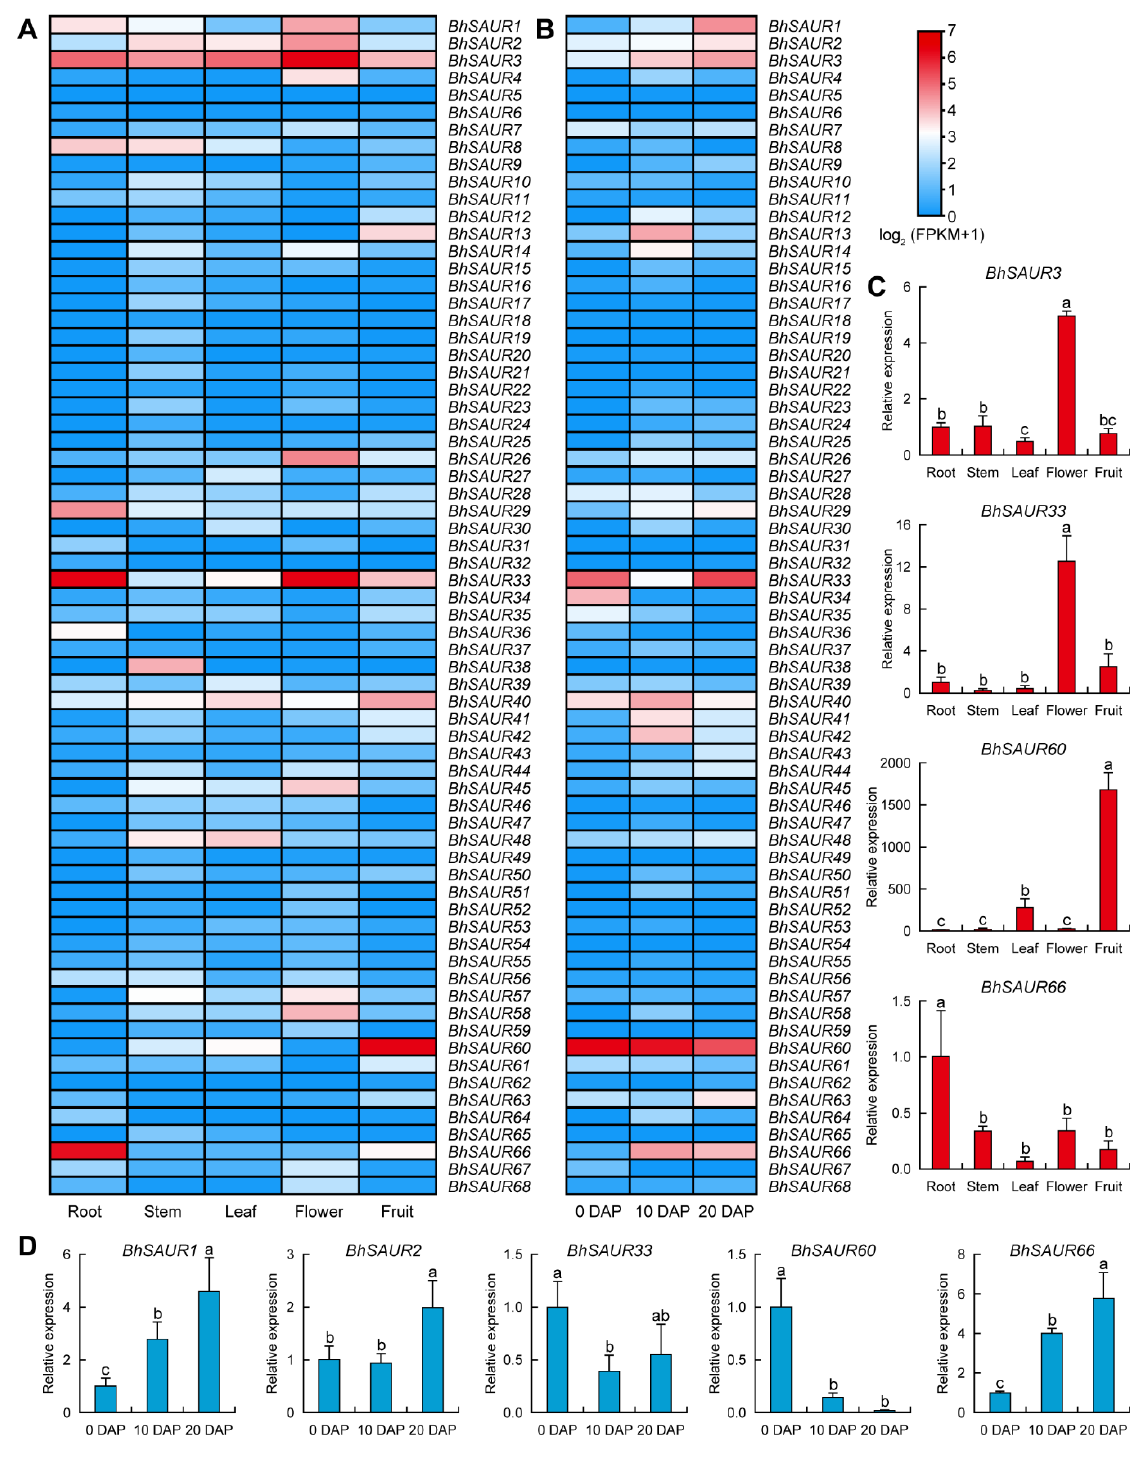
Figure 6. Expression characterization of the BhSAUR genes. ( A ) Expression profile of the BhSAUR genes in different tissues; ( B ) expression profile of the BhSAUR genes in fruits at different develop- mental stages. DAP, days after pollination; ( C ) validation of the expression of some BhSAUR genes in different tissues. Values are means ± SDs ( n = 3); ( D ) validation of the expression of some BhSAUR genes in fruits at different developmental stages. Values are means ± SDs ( n = 3). Different lowercase letters in ( C , D ) indicate significant differences determined by one-way ANOVA with Duncan’s test ( p < 0.05).